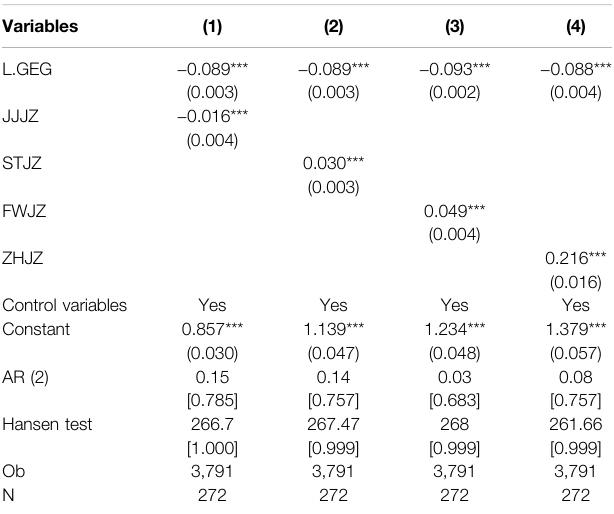
TABLE 11 | Remove special year ’ s